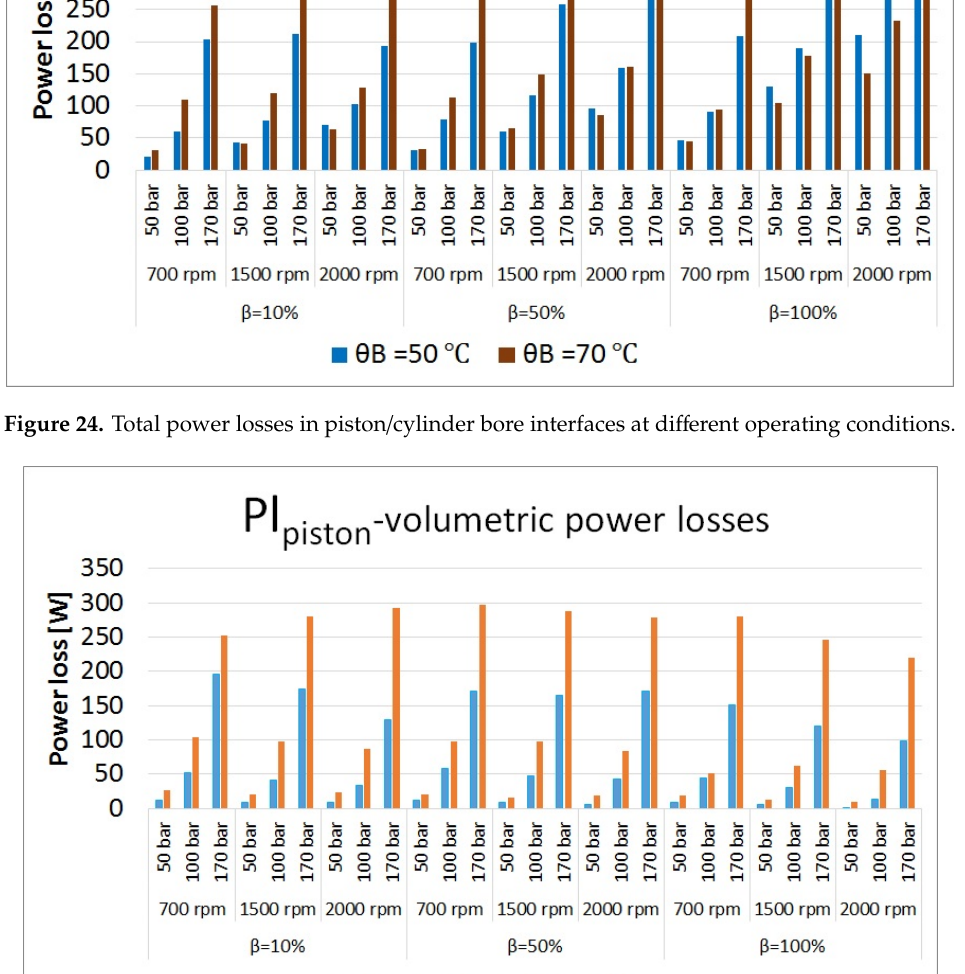
Figure 25. Volumetric power losses in piston/cylinder bore interfaces at different operating conditions.